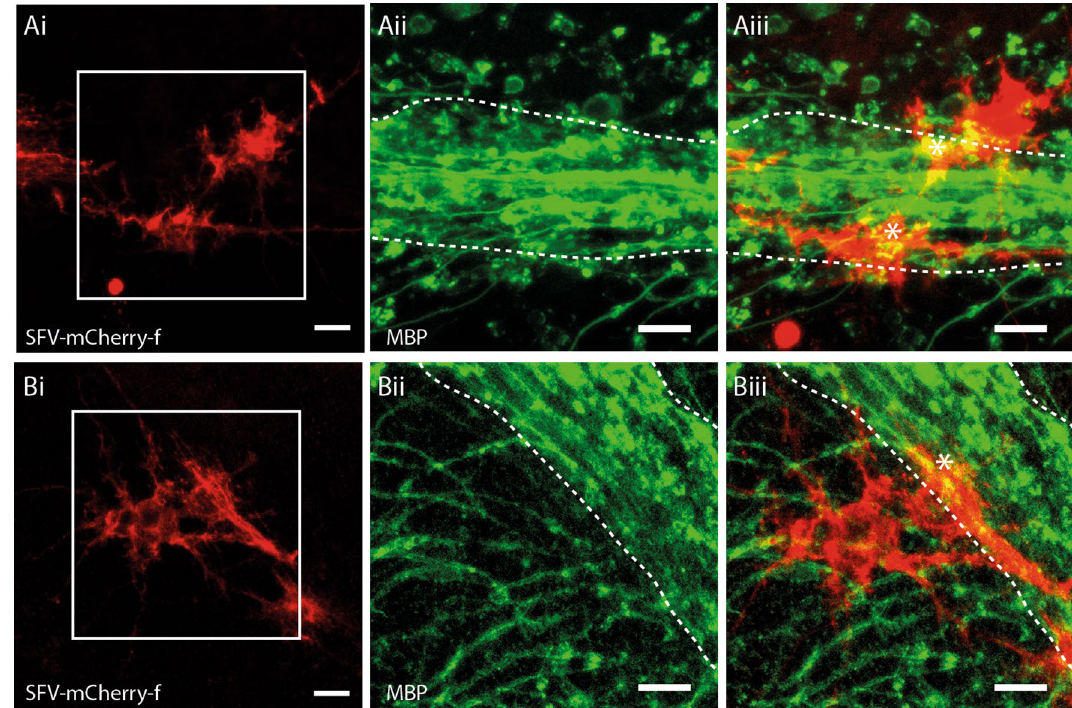
Figure 2. SFV transduced astrocytes are morphologically and antigenically distinct from OL. ( Ai , Bi ) mCherry-f labelled glia in cerebellar white matter exhibiting complex finely branching process fields typical of astroglia. ( Aii , Bii ) Enlarged view of the boxed areas shown in ( Ai) /( Bi ) showing the major white matter paths (dashed white lines) with MBP + OL processes (green) branching into the granule cell layer. ( Aiii , Biii ). Merged image showing mCherry-f fluorescence and MBP immunoreactivity from the same enlarged views shown in ( Aii )/( Bii ). White dashed lines indicate major white matter paths. In contrast to OL (Fig. 1) SFV labelled astrocytes lack cellular processes aligned in parallel with the major white matter tracks, or linear segments of MBP/process localization. Astrocytes exhibit patches of MBP co-localization (*) suggesting contact with MBP + profiles within cerebellar white matter. Scale bars in all panels 20